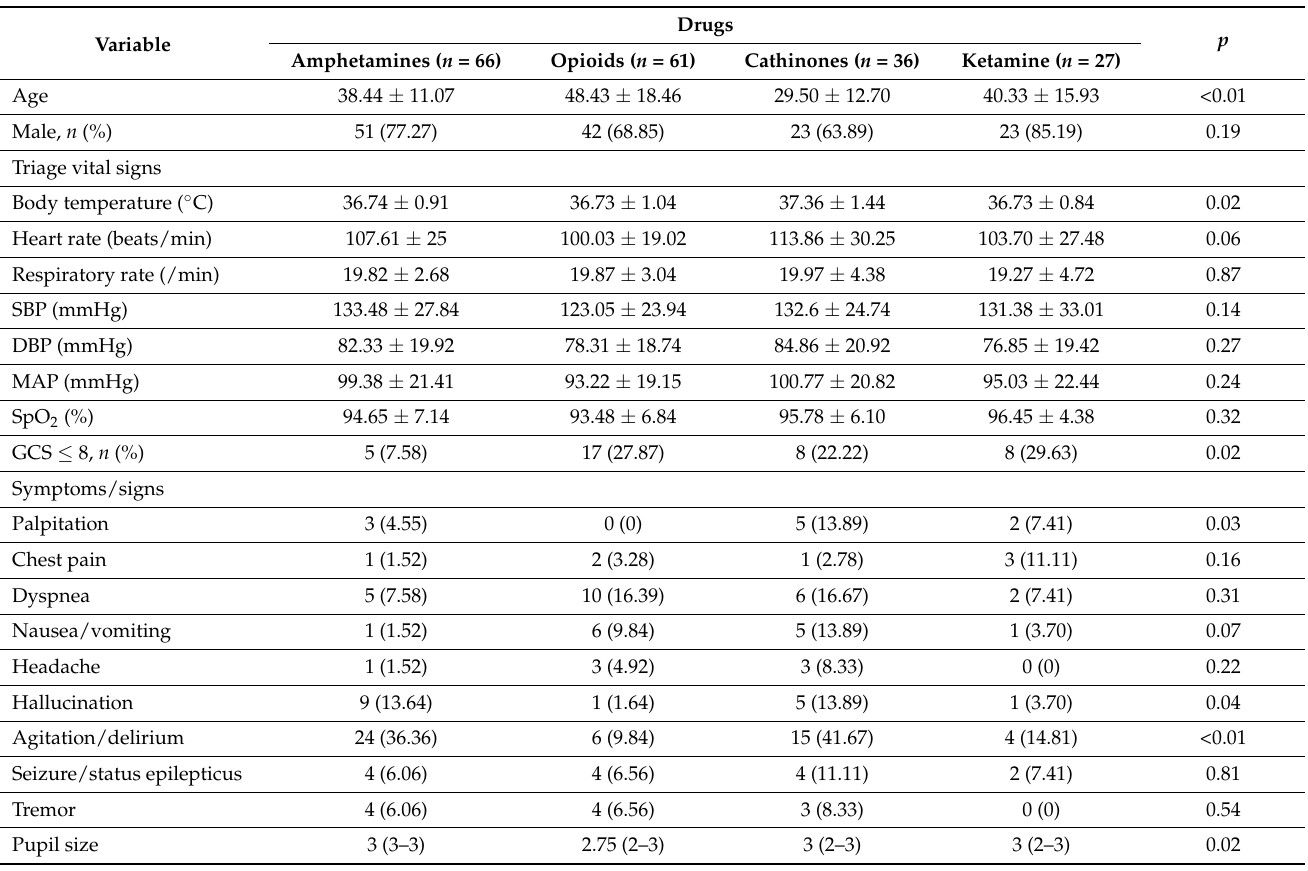
Table 1. The clinical manifestations of the main drug